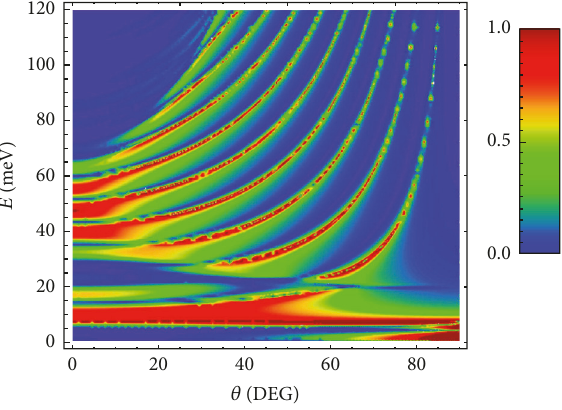
Figure 5: (Color online) (a) (𝐸,𝜃) contour plot of the transmission through a double barrier for spin-up electrons. The width and height of the barriers are 𝑊 = 50 nm and 𝑈 = 50 meV, respectively, the interbarrierseparation 𝑑 = 100 nm,andthefield 𝐸 𝑧 = 170 meV/nm.